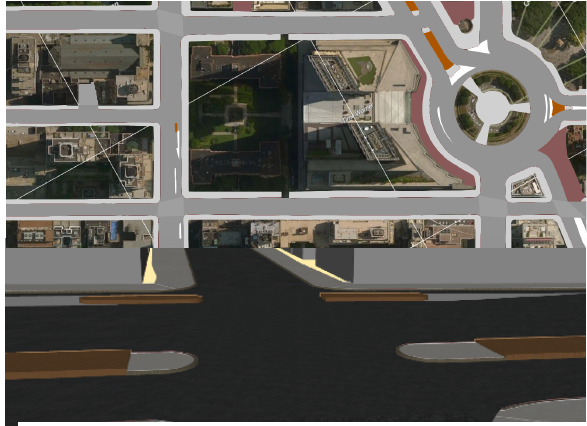
Figure 8. Visualization of the achieved